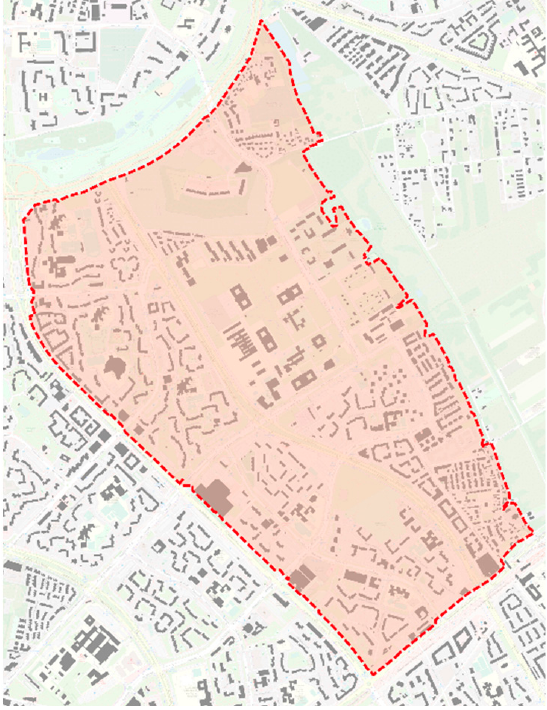
Figure 4. The area of actual analyses. Source: own study.